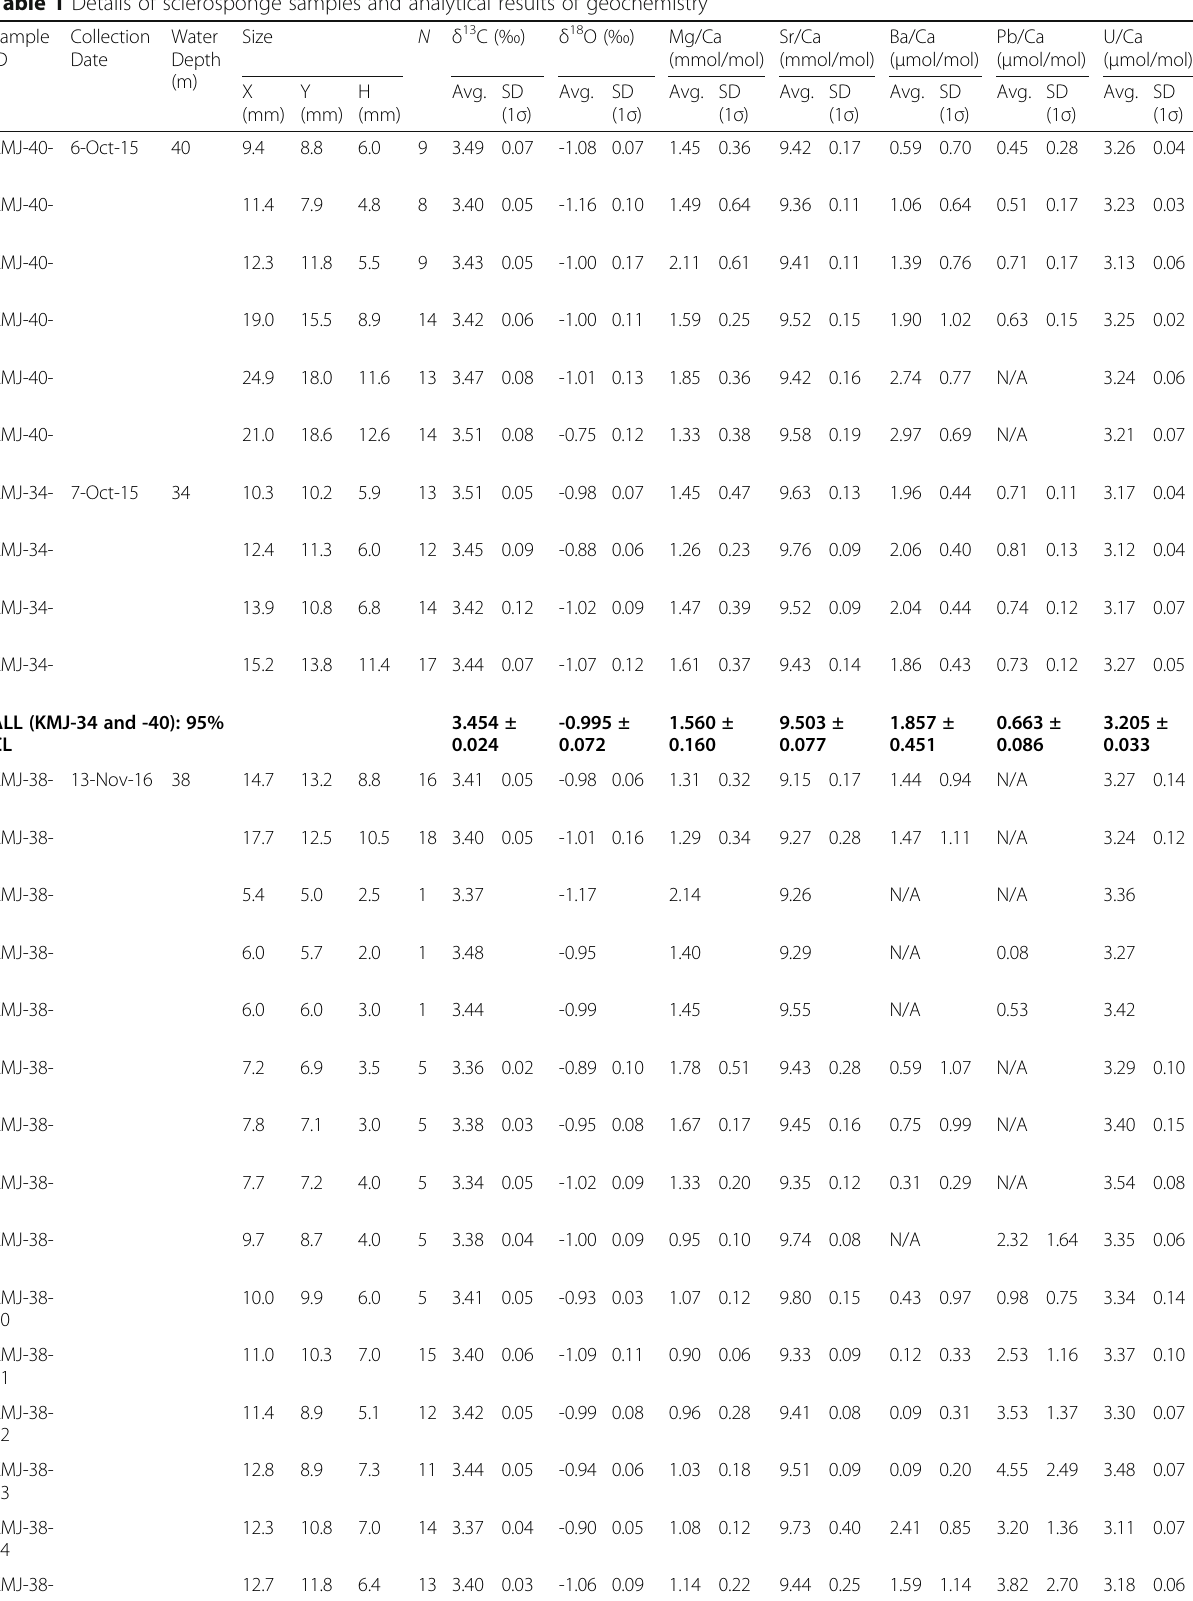
Table 1 Details of sclerosponge samples and analytical results of